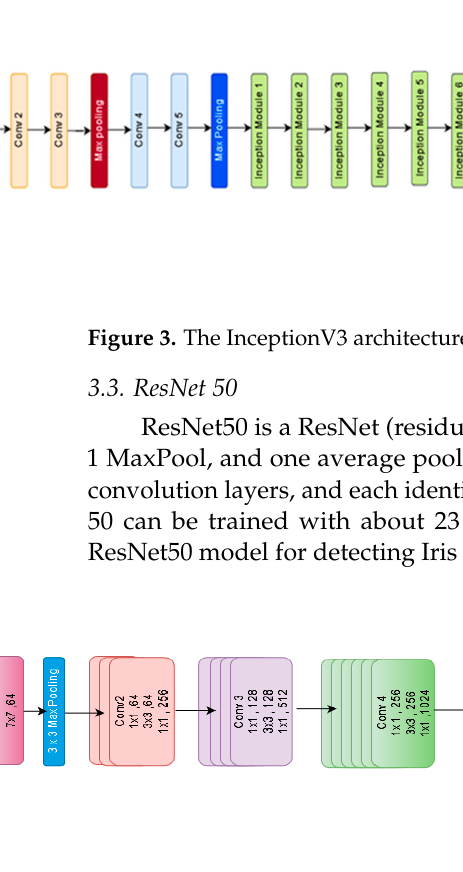
Figure 2. The VGG-16 architecture, designed for iris liveness detection.